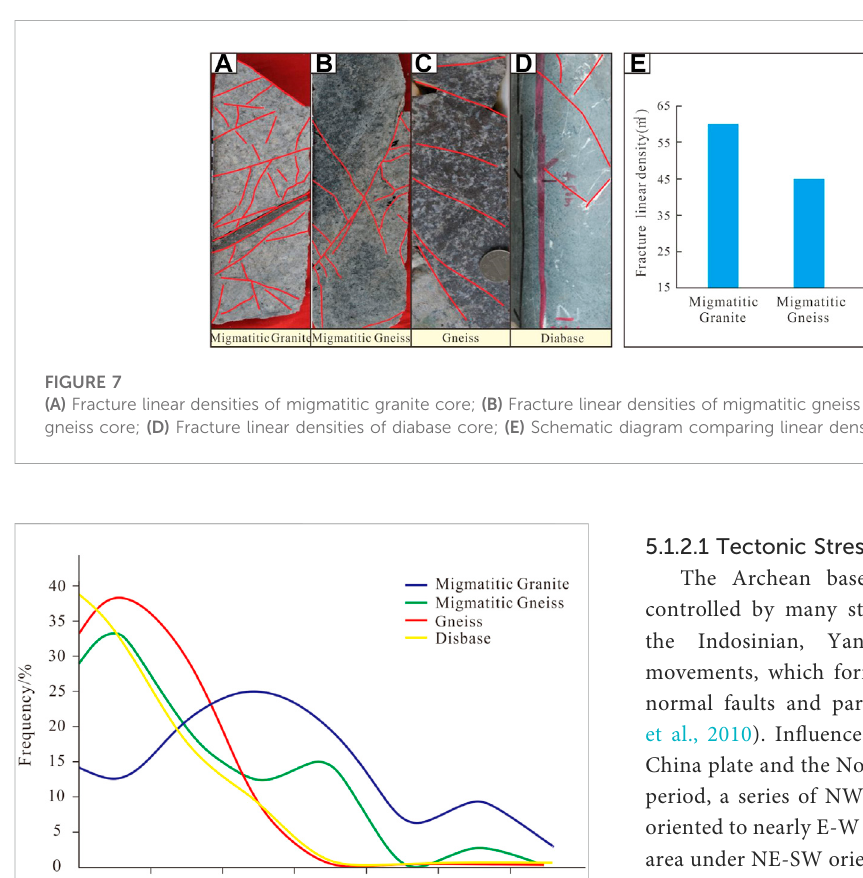
FIGURE 8 The fracture linear densities of different lithologies of Archaean buried hill in the study area obtained from imaging logging